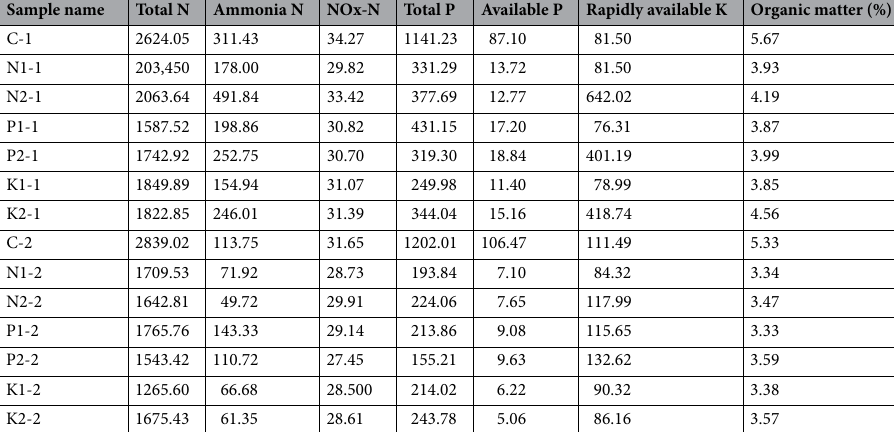
Table 1. Soil physical and chemical properties and nutrient elements